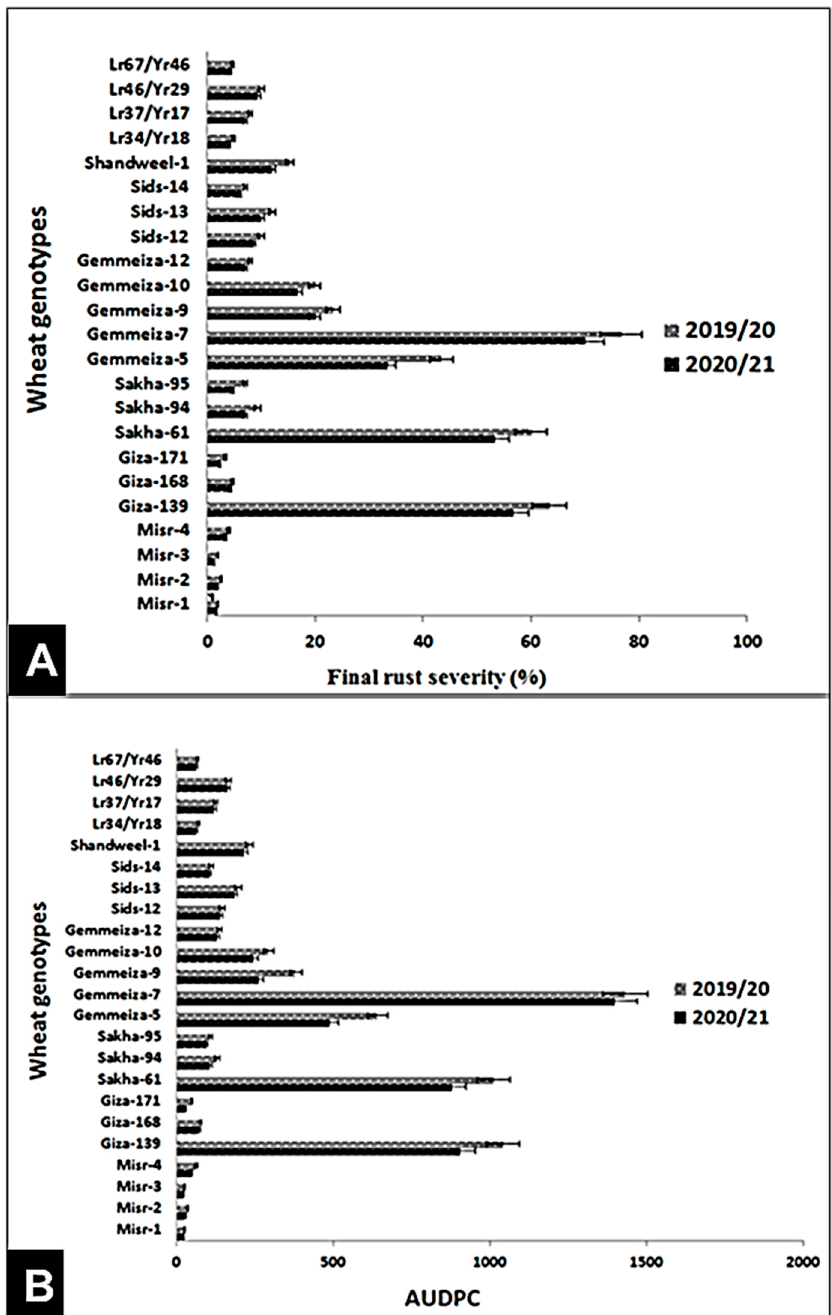
Figure 3. Final rust severity (%) ( A ) and AUDPC ( B ) of 23 wheat genotypes against leaf rust under field conditions at Kafr El-Sheikh governorate, during the 2019/20 and 2020/21 growing seasons.